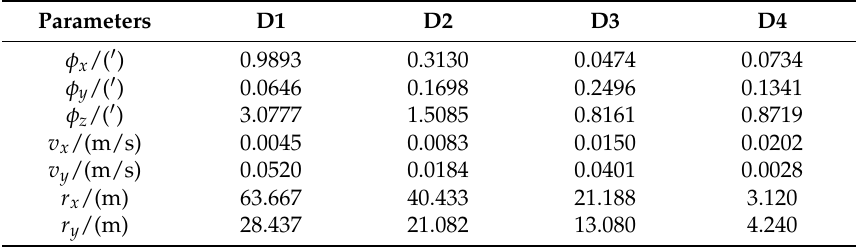
Figure 8. Estimation errors of conventional adaptive Kalman filter (AKF) with different ranges of random communication delay: ( a ) attitude estimation errors; ( b ) velocity estimation errors; ( c ) position estimation errors. Table 1. RMS errors of polar cooperative navigation of multi-UUVs based on conventional